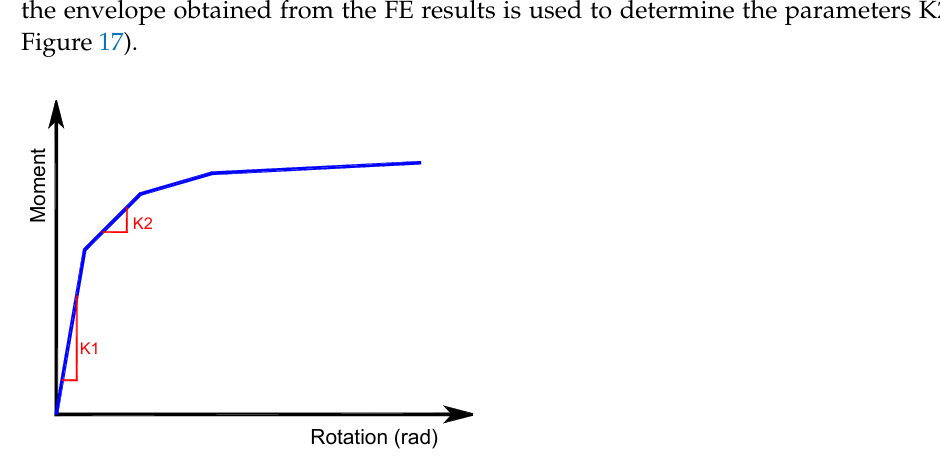
Figure 17. Piecewise linear idealization of the moment–rotation envelope curves.